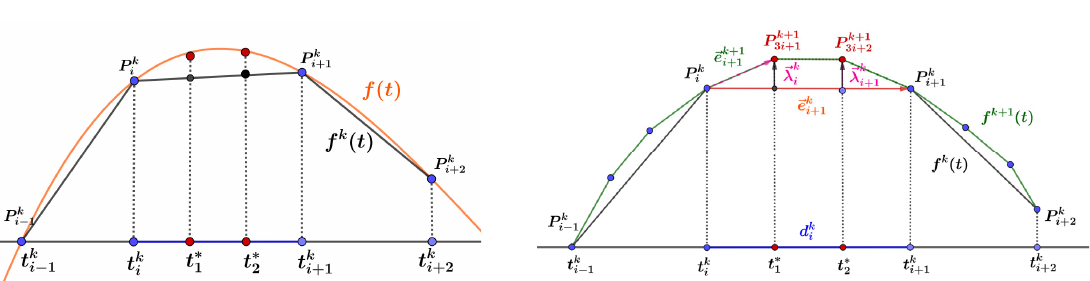
, P k , P k , P k , and i − 1 i i + 1 i + 2 , P k , P k , P k . Right: insertion of the new i − 1 i i + 1 i + 2